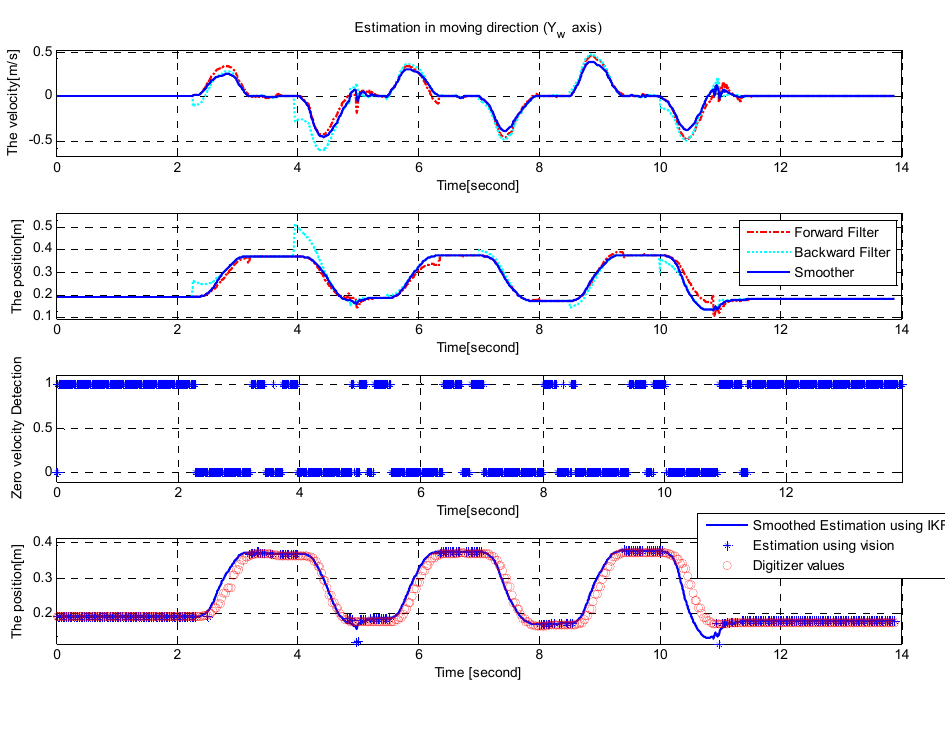
Y axis moving experiment). w